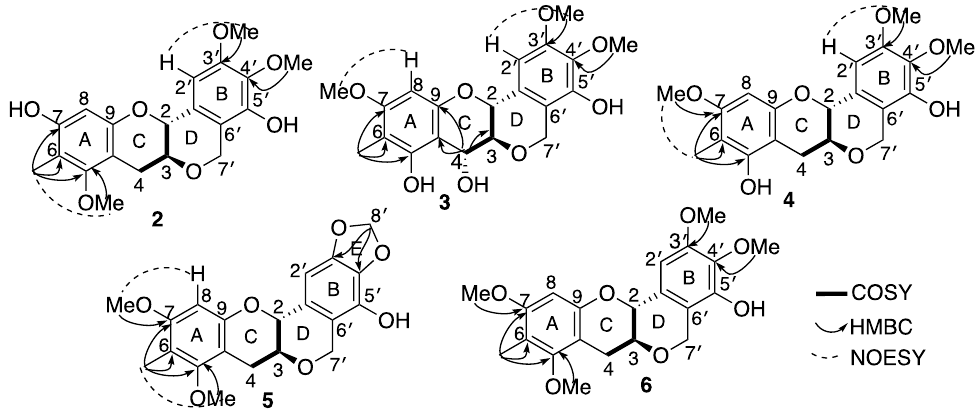
Figure 3. Key diagnostic 2D NMR correlations of compounds 2 – 6 .